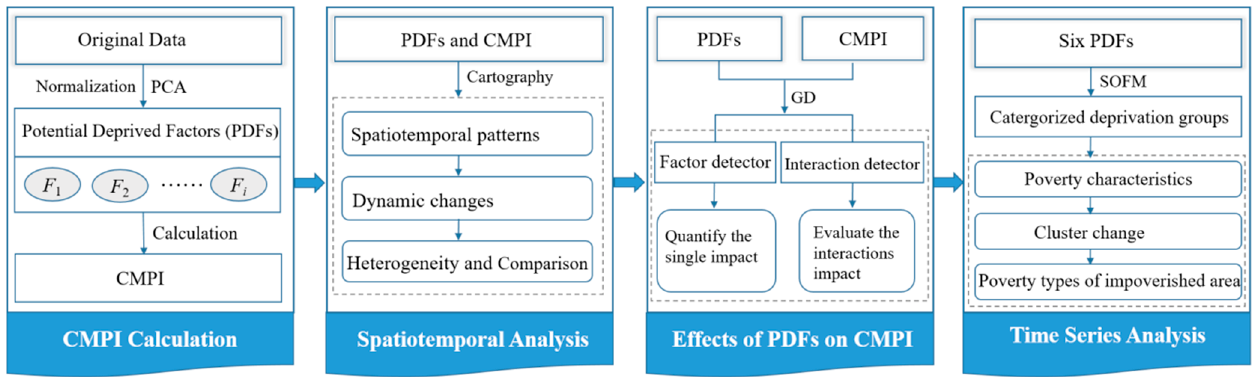
Figure 2. Overall methodological framework.